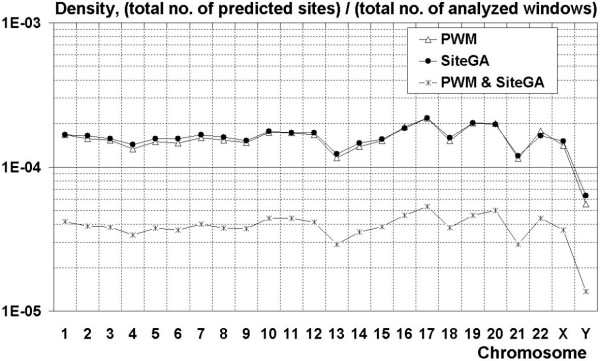
Comparative analysis of predicted SF1 BSs densities for human chromosomes. X-axis – number of human chromosomes (1–22, X, Y); Y axis (logarithmic scale) – ratio of no. of predicted sites to the total no. of analyzed window positions.